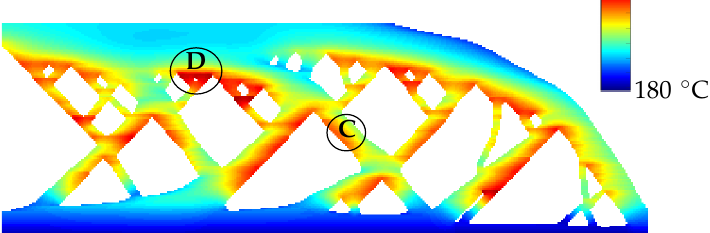
Figure 6. Contour plot for maximum temperature attained at each point of the part geometry during the entire build simulation using the layer-by-layer reference model. The region labelled as D shows higher maximum temperatures than that near the region C, while both regions are in the vicinity of a 45 ◦ overhang. The temperature scale spans from initial temperature T 0 = 180 ◦ C to the maximum value predicted by the